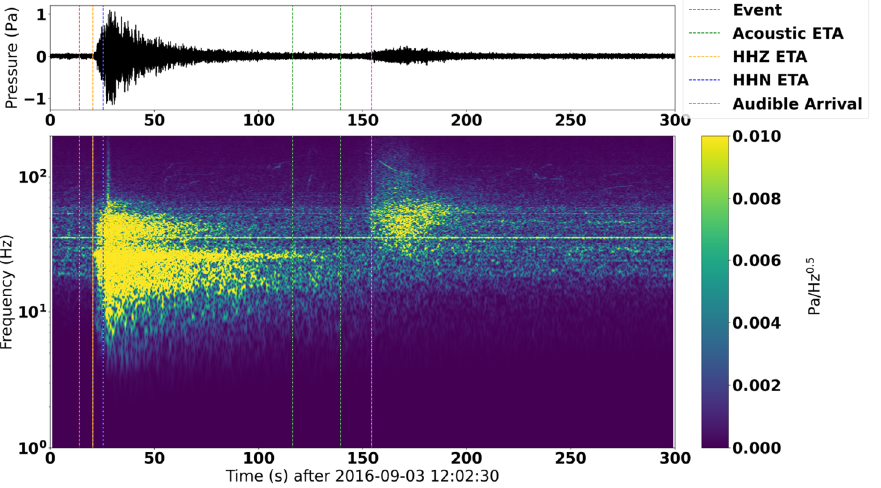
Figure 14. ( top ) Time trace and ( bottom ) spectrogram of OSU1-W during the 5.8 M w earthquake that occurred on 3 September